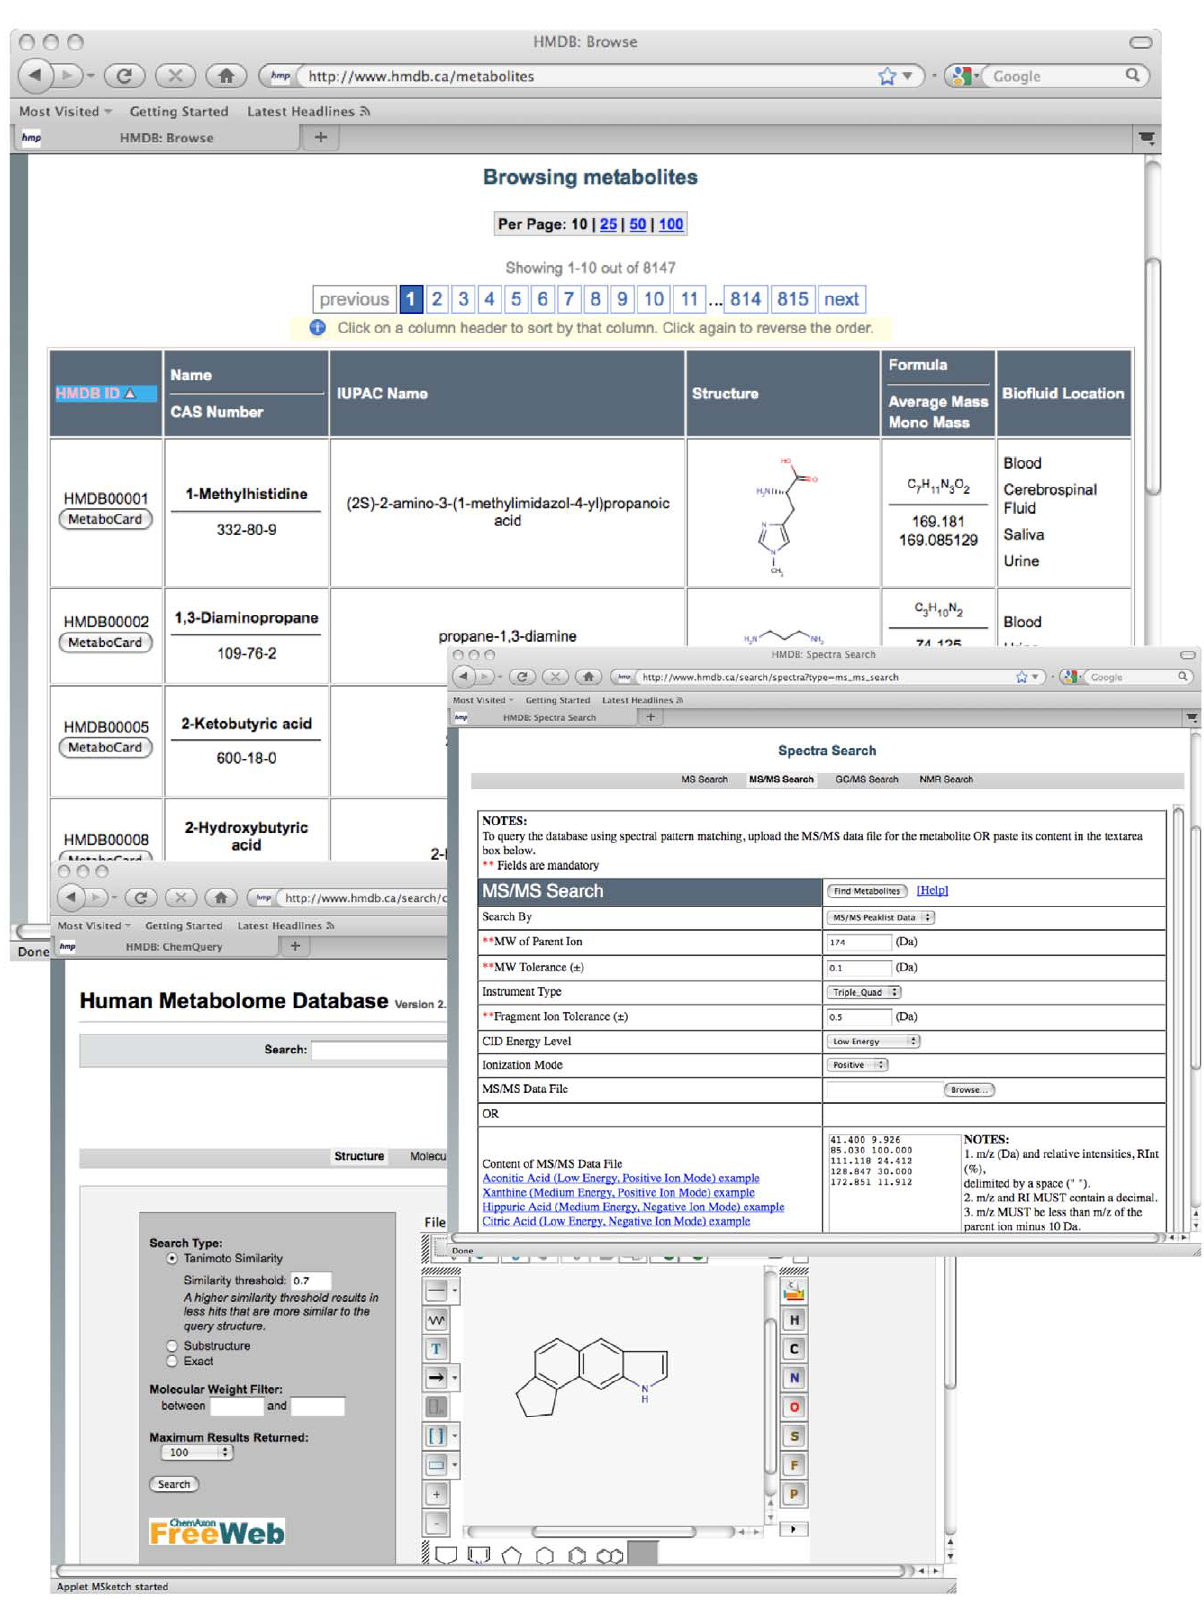
Figure 2. A screenshot montage illustrating the types of viewing and searching options available in HMDB (http://www.hmdb.ca).